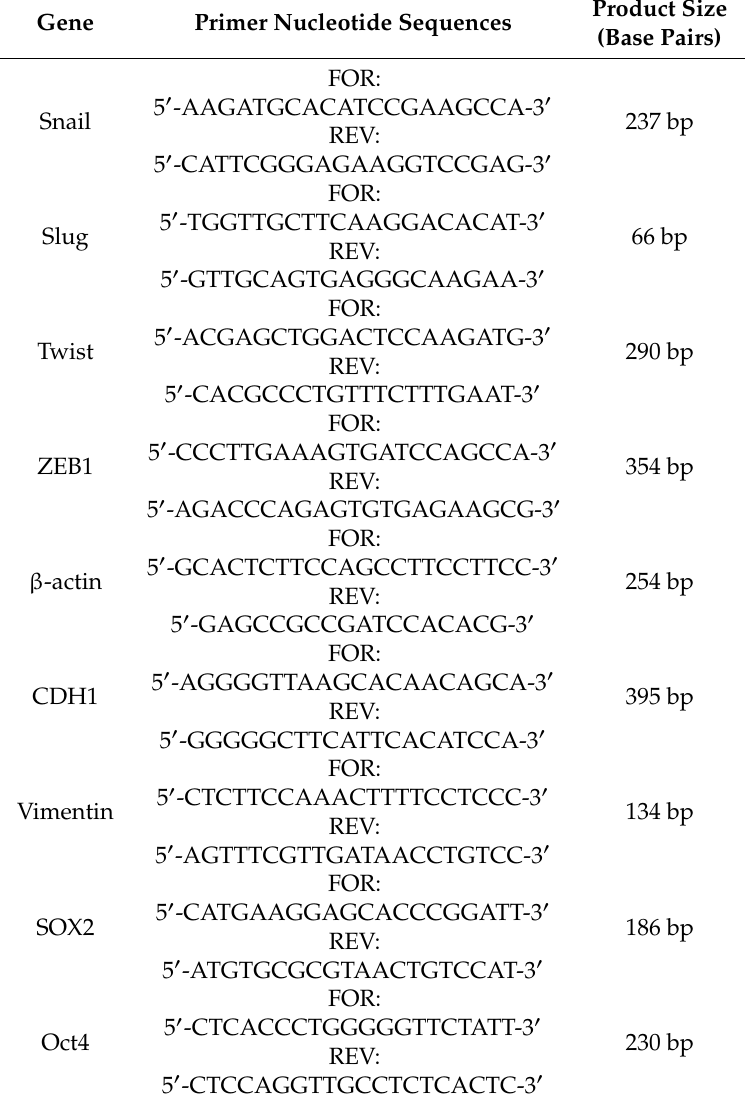
Table 1. Primers used for RT-PCR. Gene Primer Nucleotide Sequences